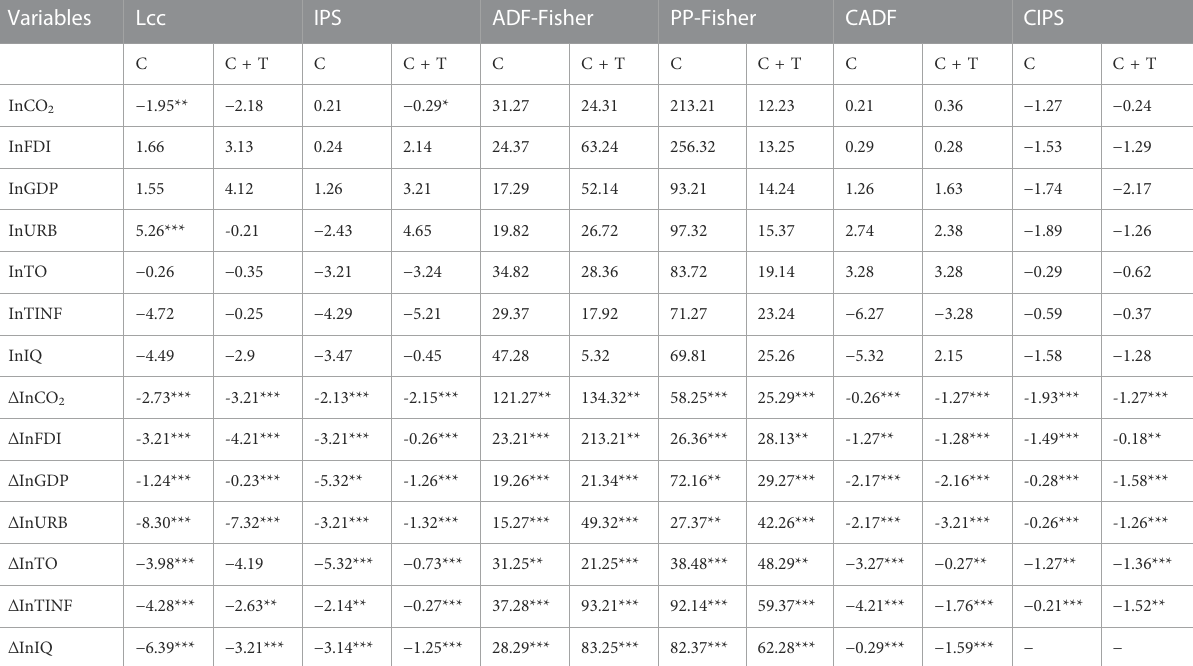
TABLE 3 Findings of the panel unit root